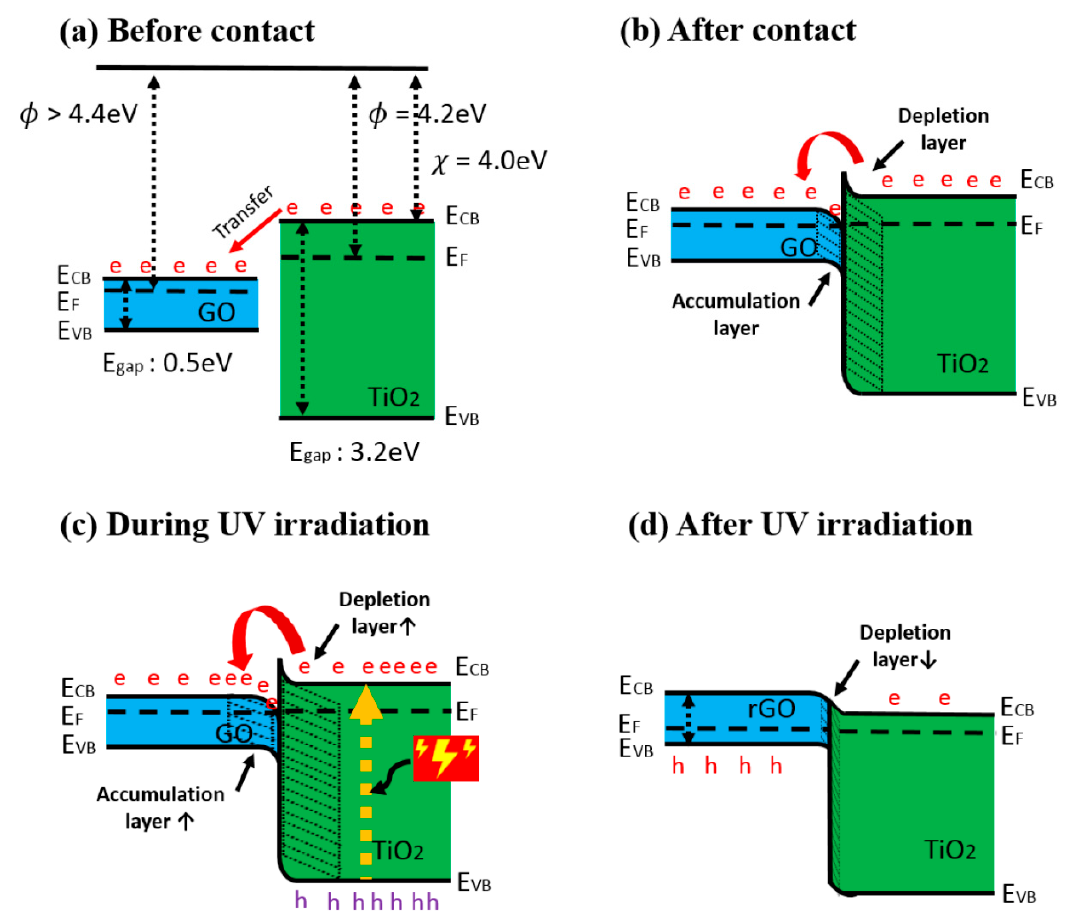
Figure 2. Band diagram of GO / TiO 2 composite ( a ) before contact, ( b ) after contact, ( c ) during UV irradiation, and ( d ) after UV irradiation. (e: electron, h: hole), adapted from [51].